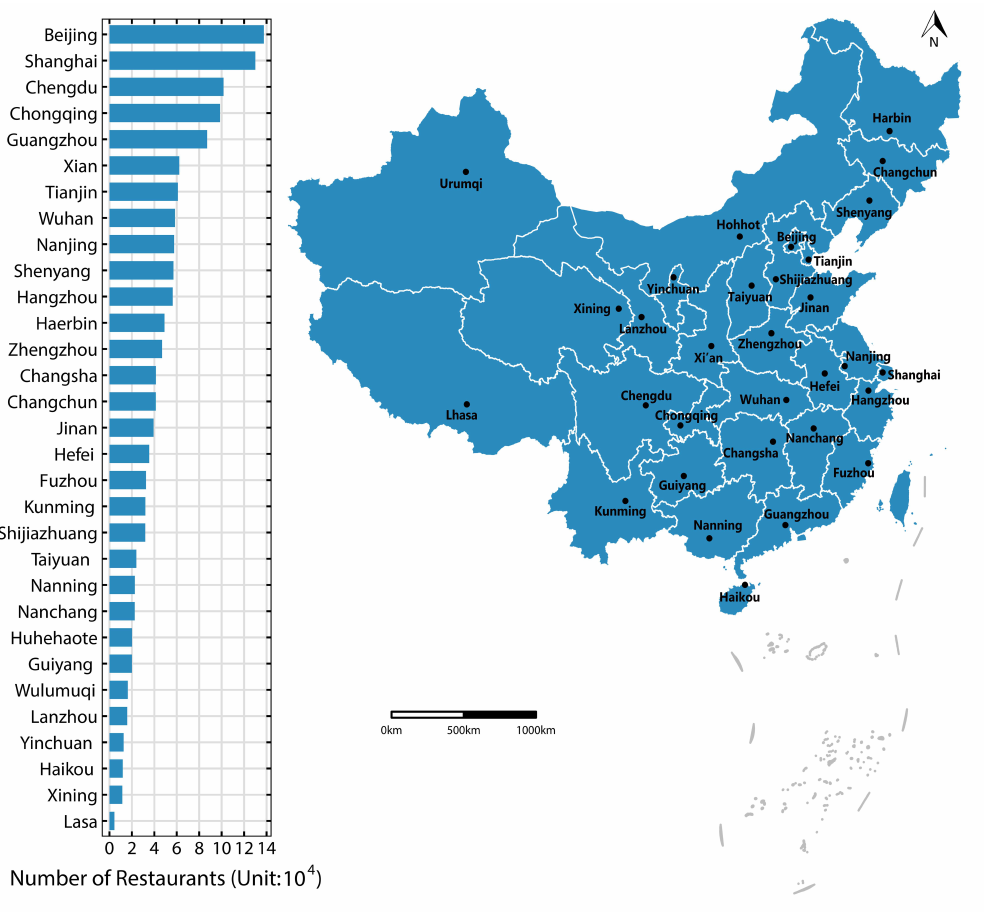
Figure 1. Number of restaurants in each selected